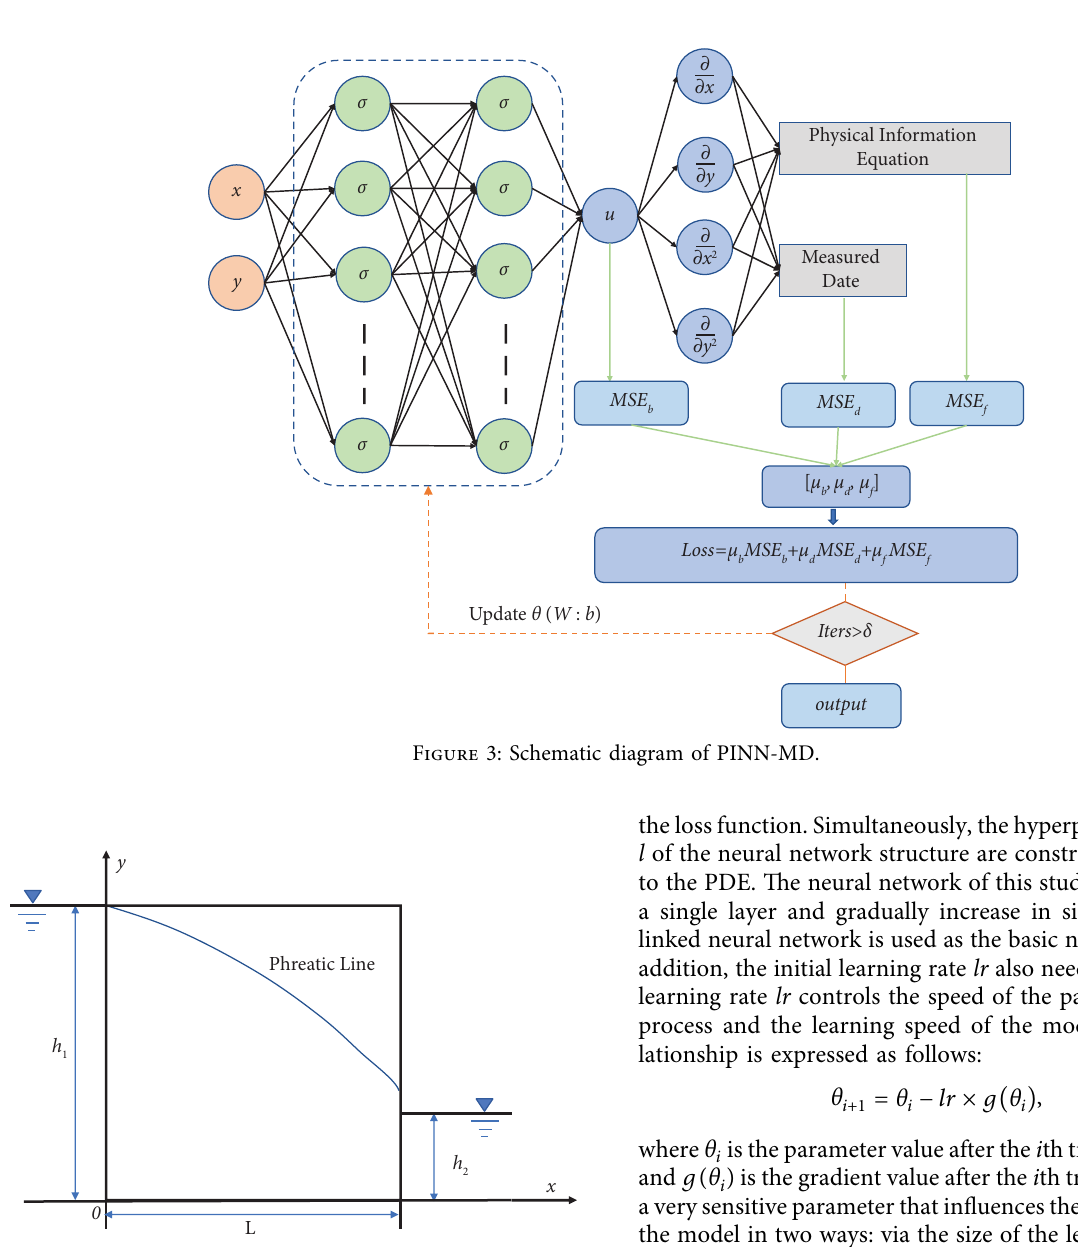
Figure 4: Diagram of a numerical example of the